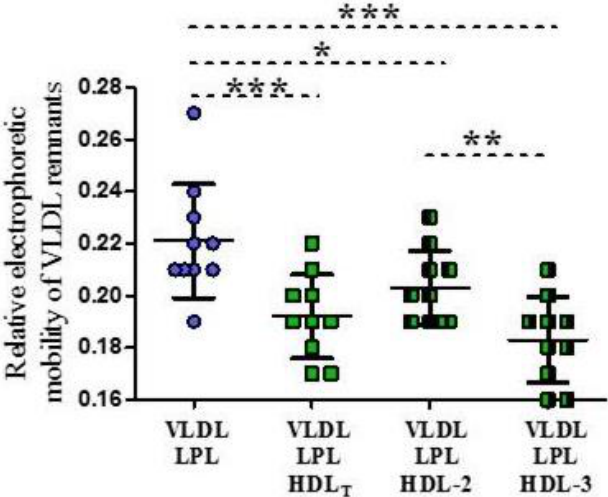
Figure 4. Exemplary electrophoresis and electropherogram of VLDL control and VLDL remnants produced during LPL- mediated lipolysis in the absence or presence of HDL T and HDL subpopulations: HDL-2 and HDL-3; ß mobility corresponds to LDL, pre-ß mobility corresponds to VLDL, ɑ mobility corresponds to HDL.